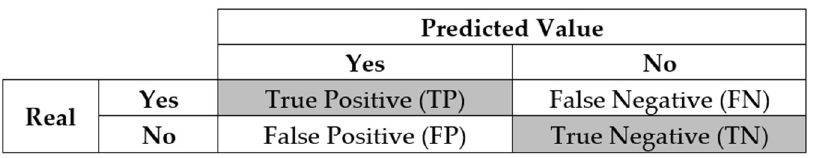
Figure 2. Confusion matrix for binary classification problems (adapted from [27]).